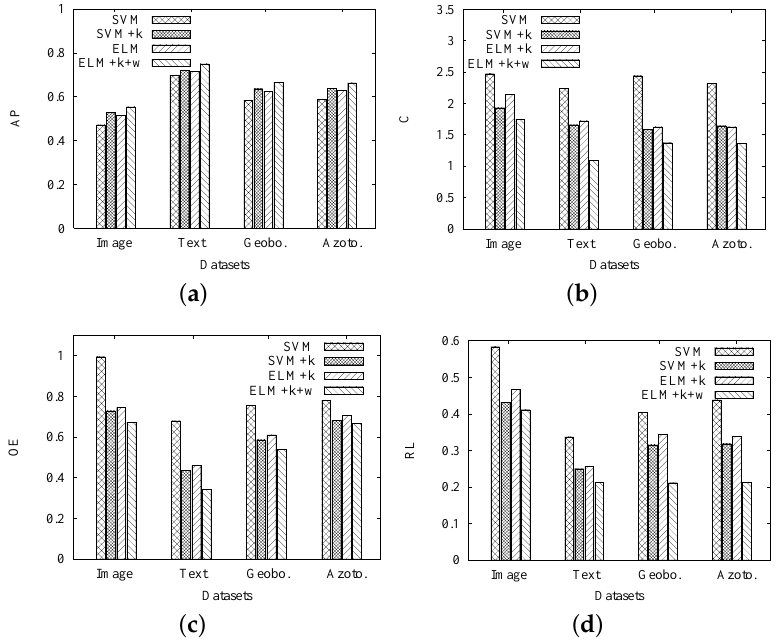
Figure 4. Gradual effectiveness evaluation of each contribution in Multi-instance Multi-label with Extreme Learning Machine (MIMLELM). ( a ) Gradual evaluation on average precision ( AP ); ( b ) gradual evaluation on converage ( C ); ( c ) gradual evaluation on one-error ( OE ); ( d ) gradual evaluation on ranking loss ( RL